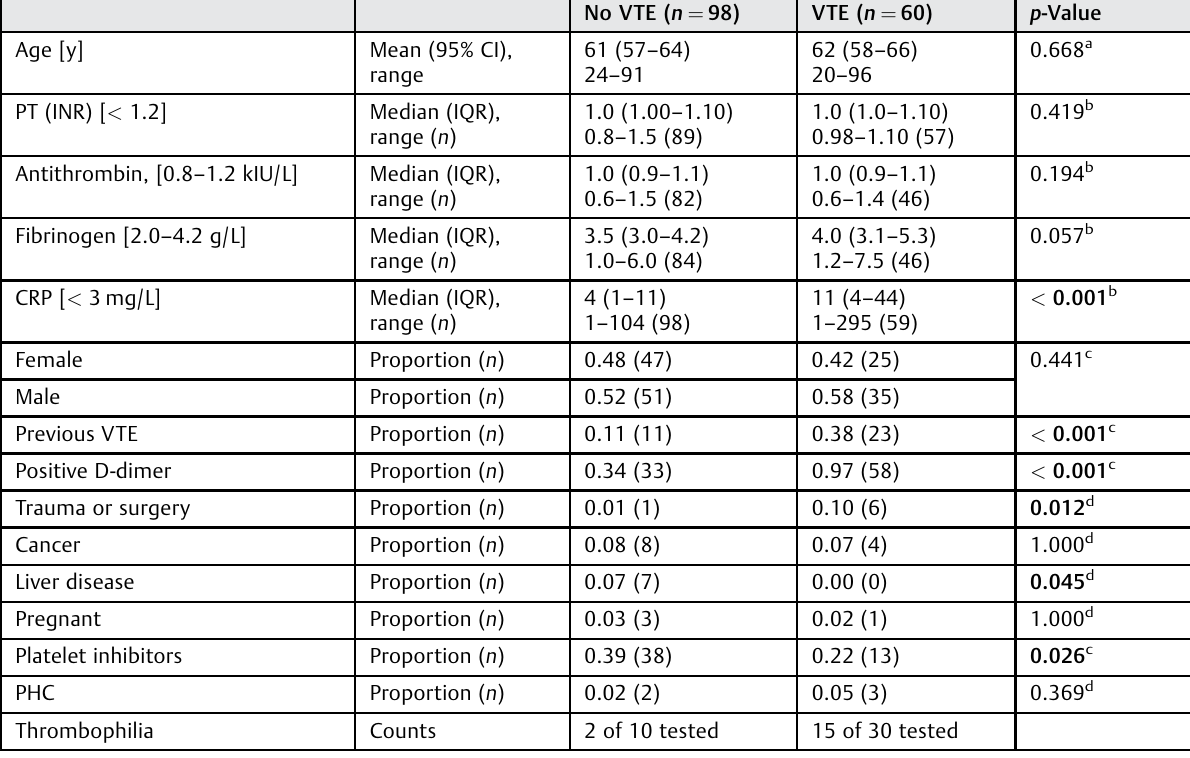
Table 1 Patient characteristics for patients with and without